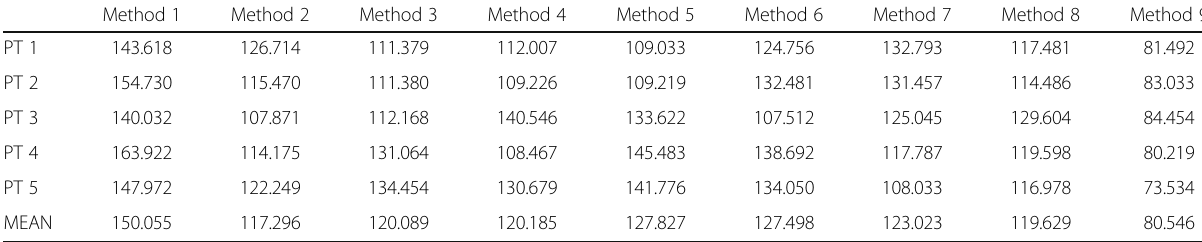
Table 1 The mean grey values of each image of aligners cleaned by each of the nine cleaning strategies in each of the five patients, showing the mean calculated for each cleaning method